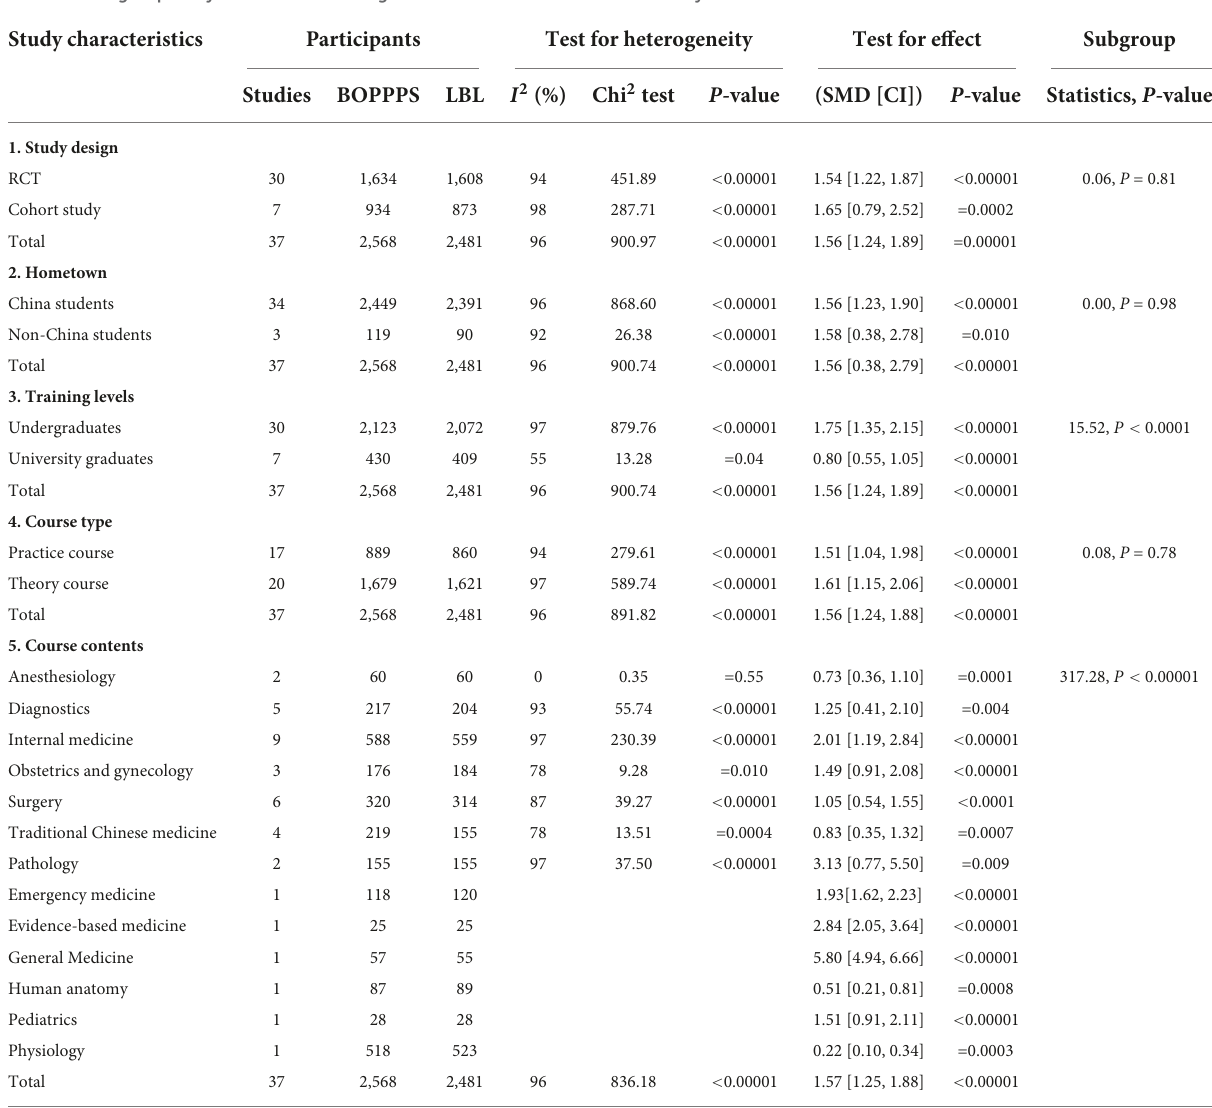
TABLE 2 Subgroup analyses of final knowledge examination score in this